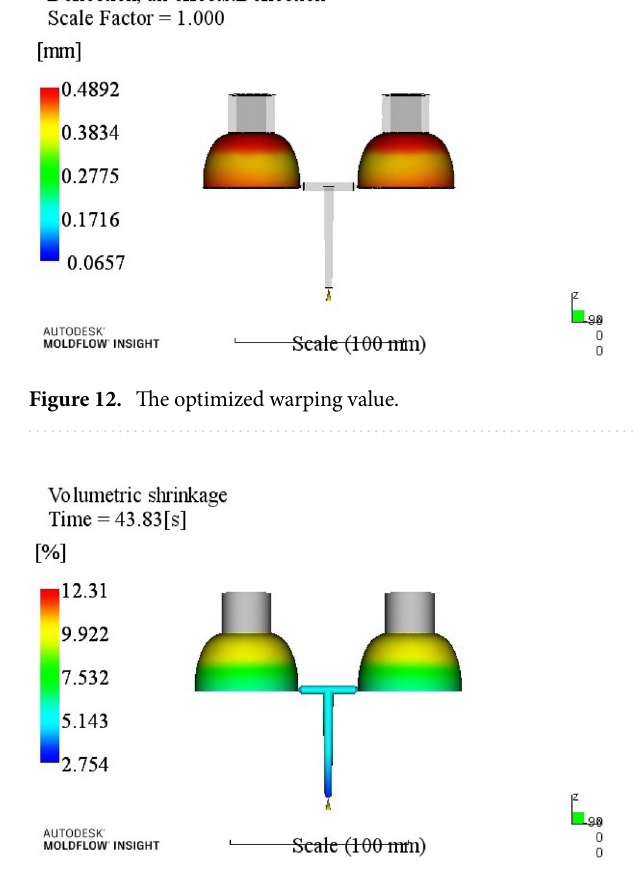
Figure 13. The optimized Volume shrinkage after